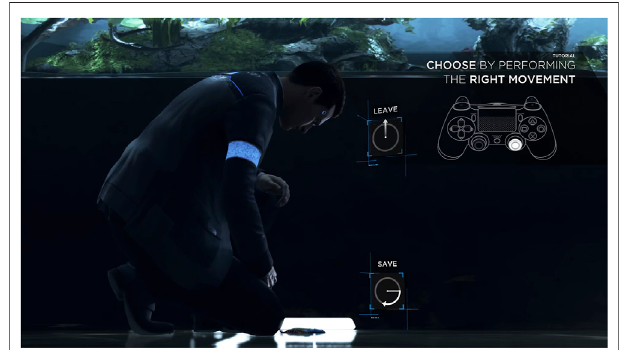
FIGURE3| Anoverlayed interface showsplayershowtoperform oneof the two available interactions. By moving the right analogue stick away from their body (up), players can decide to leave the scene immediately without saving the fi sh. By moving the stick to the right and then perform quarter a clockwise circle, players can save the fi sh by putting it pack in the tank. Screenshot from Detroit: Become Human (Quantic Dream 2018) for PlayStation